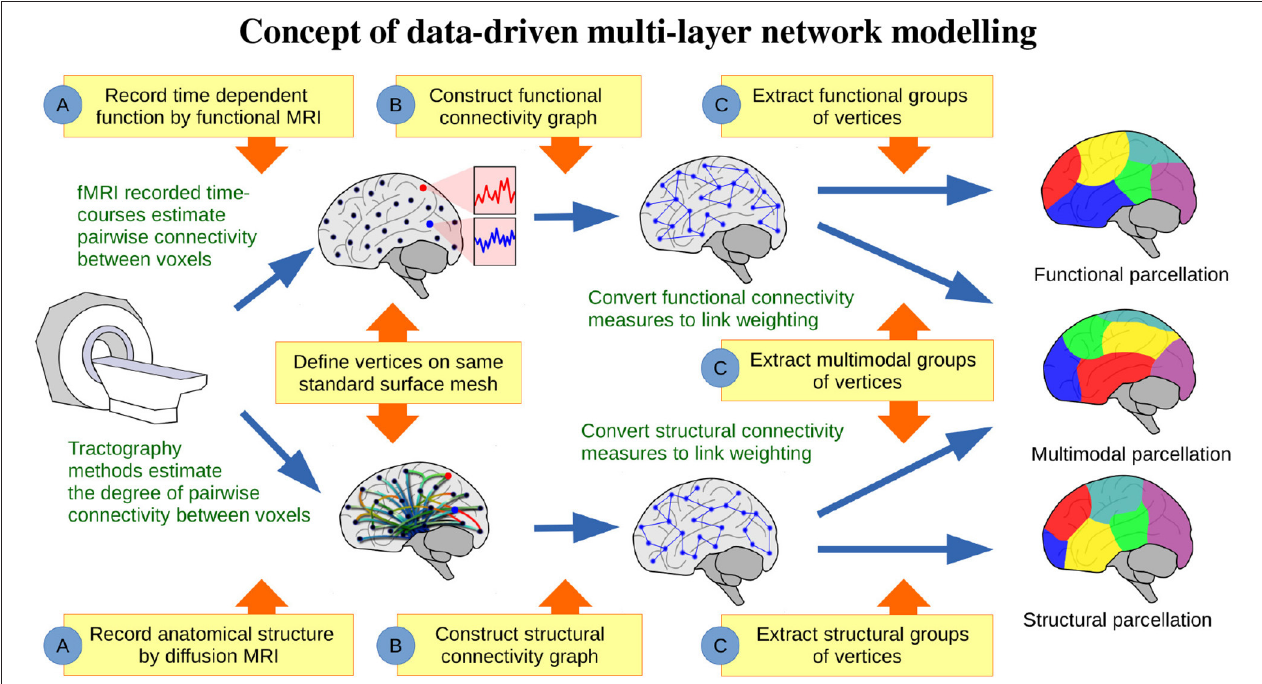
FIGURE 1 | Concept of data-driven multi-layer network modeling. (A) Based on functional and structural MRI, graphs of structural and functional connectivity are generated, (B) such that vertices are defined on the same standard surface mesh. (C) From these graphs data-driven parcellations can be inferred and compared, when modeling structure or function either individually or